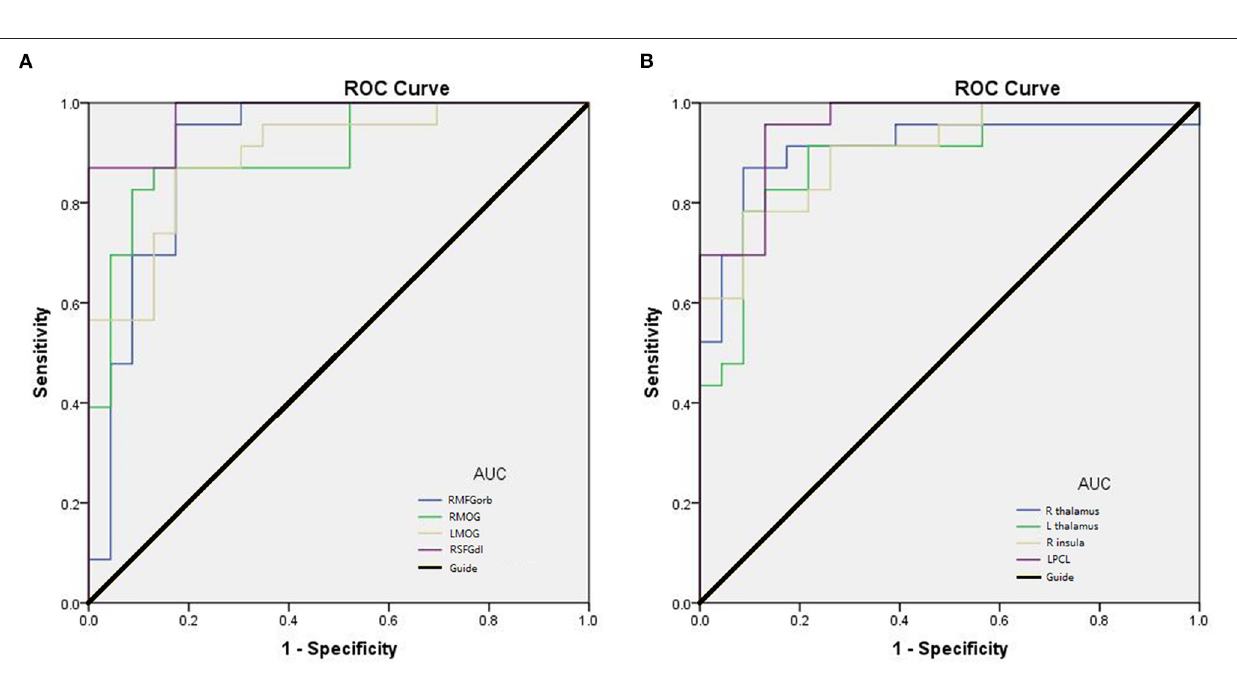
FIGURE 3 | Receiver operating characteristic (ROC) curve analysis of mean ReHo in corresponding brain regions. (A) The AUC were 0.905 [ p < 0.0001; 95% CI (0.810–1.000)] for the RMFGorb; RMOG 0.902, [ p < 0.0001; 95% CI (0.812–0.992)]; LMOG 0.896, [ p < 0.0001; 95% CI (0.806–0.986)]; RSFGdl 0.977, [ p < 0.0001; 95% CI (0.944–1.000)]. (B) The AUC were 0.909 [ p < 0.0001; 95% CI (0.821–1.000)] for R thalamus; L thalamus 0.898, [ p < 0.0001; 95% CI (0.807–0.989)]; R insula 0.907, [ p < 0.0001; 95% CI (0.825–0.990)]; LPCL 0.955, [ p < 0.0001; 95% CI (0.902–1.000)]. AUC area under the curve; CI confidence interval; R, right; L, left; RMFGorb, right orbital part of middle frontal gyrus; RMOG, right middle occipital gyrus; LMOG, left middle occipital gyrus; RSFGdl, right dorsolateral superior frontal gyrus; LPCL, left paracentral lobule.